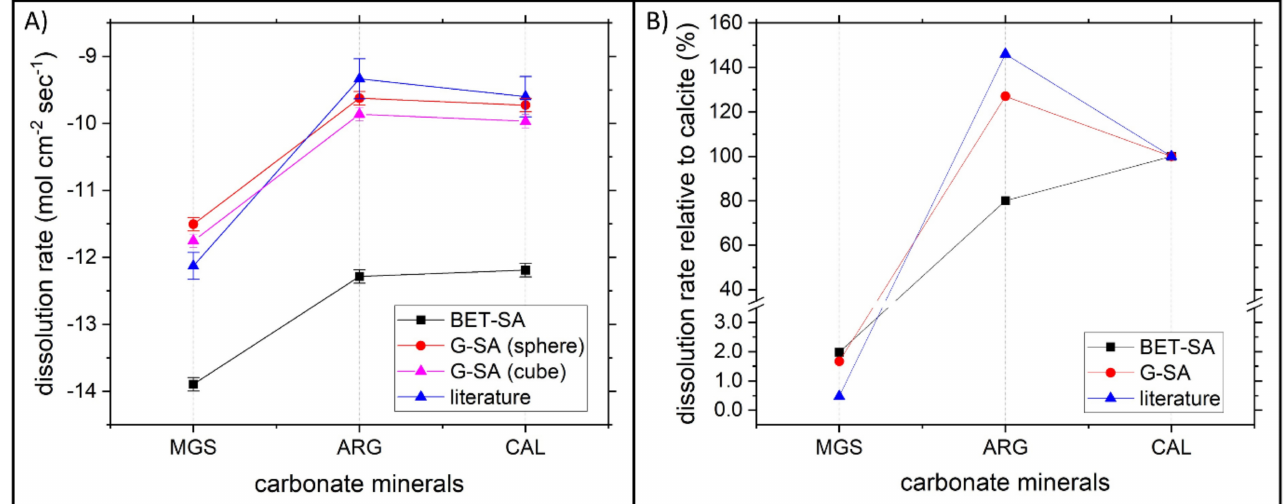
Figure 3. ( A ) Dissolution rates of MGS, ARG and CAL normalized by the surface area. Two geometrical surface areas are reported (sphere and cube approximations) together with BET surface area and literature values [30–32]. ( B ) Dissolution rate of MGS and ARG normalized with respect to